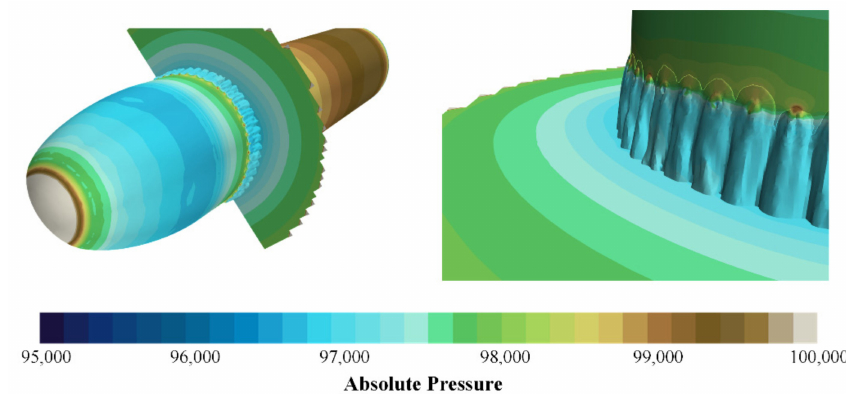
Figure 16. Distribution of pressure near the air film.